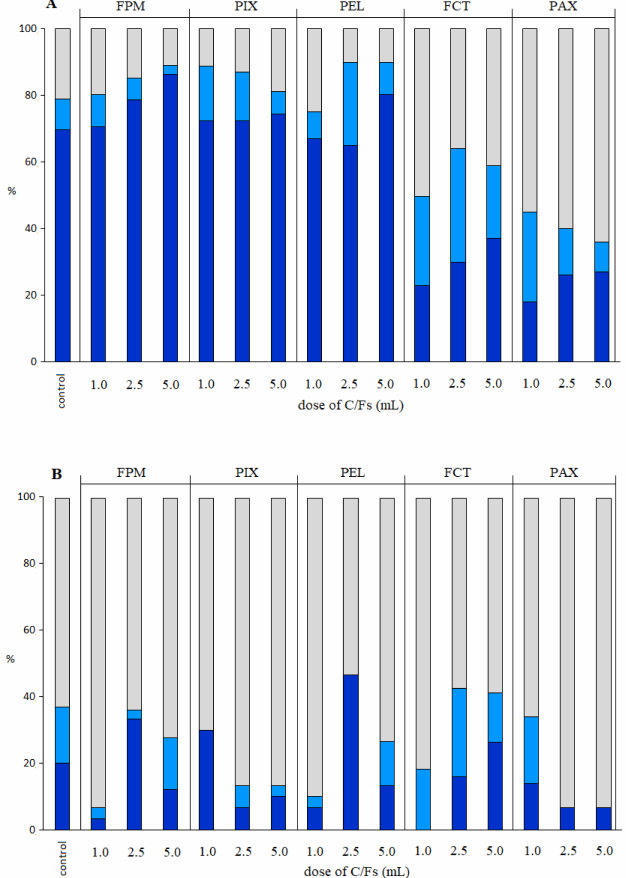
Figure 2. Distribution of MP with a diameter of 180–212 µ m ( A ) and 710–850 µ m ( B ) in the surface phase (grey), the liquid phase (light blue), and the sludge phase (dark